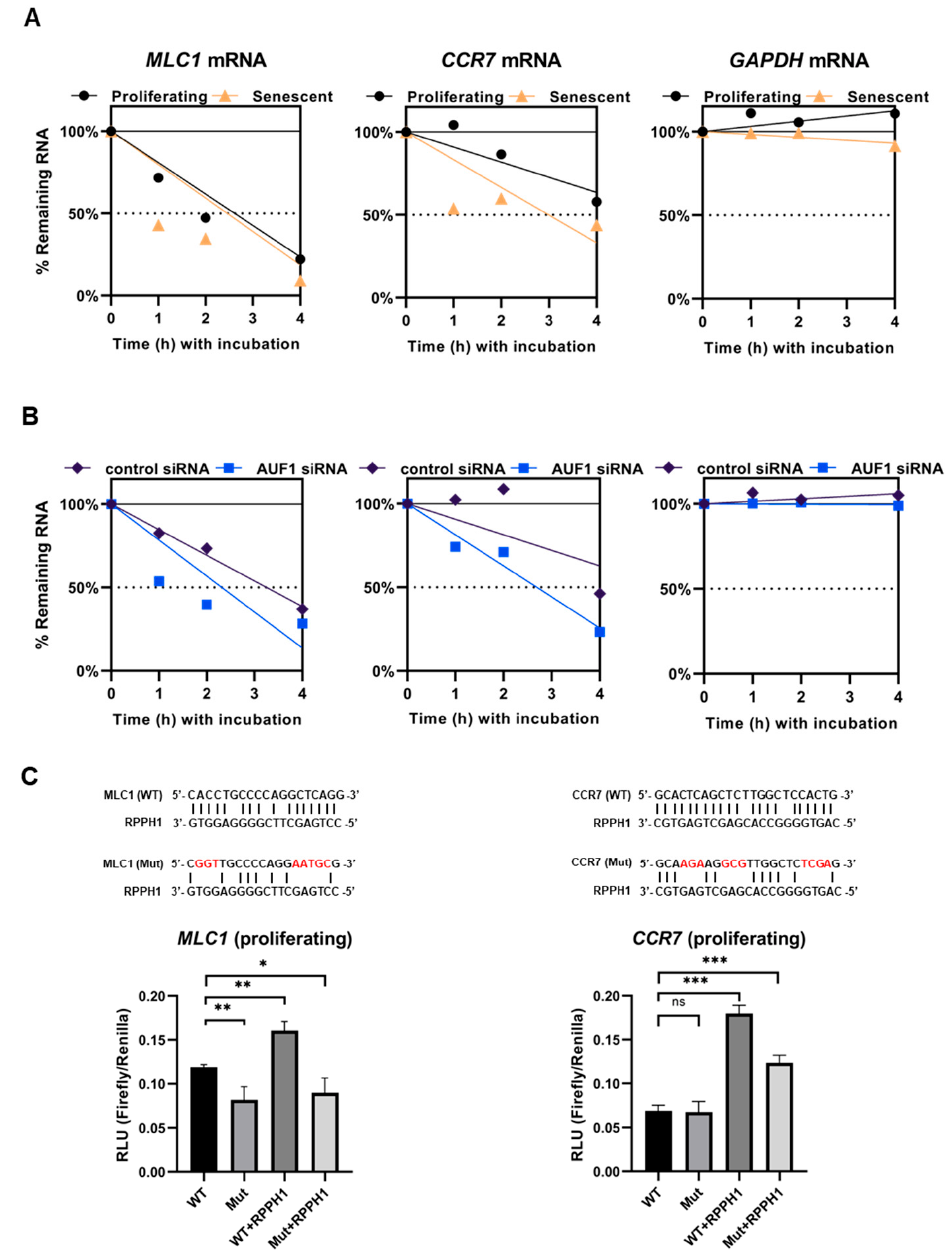
Figure 5. Target mRNAs of RPPH1 RNA are destabilized in cellular senescence. ( A ) Stability of MLC1 , CCR7 , and GAPDH mRNAs in proliferating or senescent WI-38 cells. ( B ) Stability of MLC1 , CCR7 , and GAPDH mRNAs in proliferating WI-38 cells after transfection of Control or AUF1 siRNA (~48 h) as measured by RT-qPCR. ( C ) Luciferase reporter assay with constructs bearing putative RPPH1 binding sites. Reporters carrying an indicate site (sequence above bar-graphs) were co-transfected with RPPH1 expression vector, and luciferase activity was measured. Data in ( A – C ) are representative of three independent experiments. Asterisks denote statistical significance (Student’s t test): ns p > 0.05, * p ≤ 0.05, ** p ≤ 0.01, *** p ≤ 0.001.